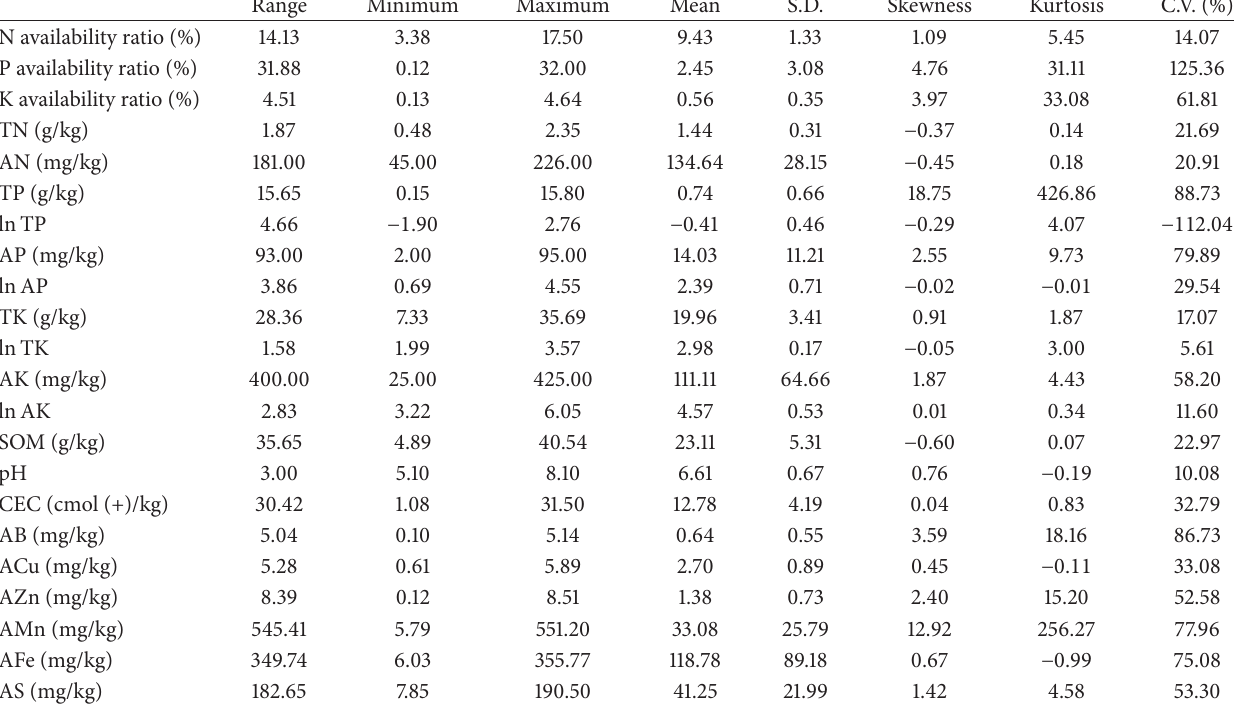
Table 1: Summary statistics for macronutrient elements and other selected properties of paddy soils (𝑛 = 636) . Range Minimum Maximum